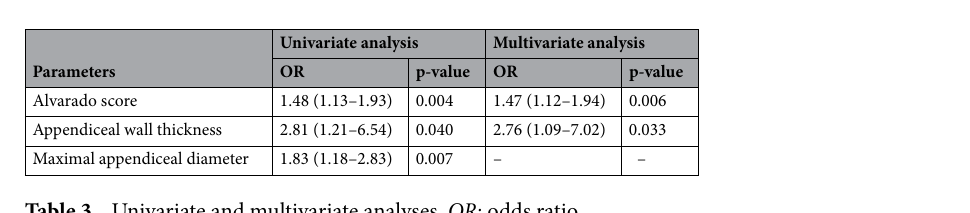
Table 3. Univariate and multivariate analyses. OR: odds ratio.